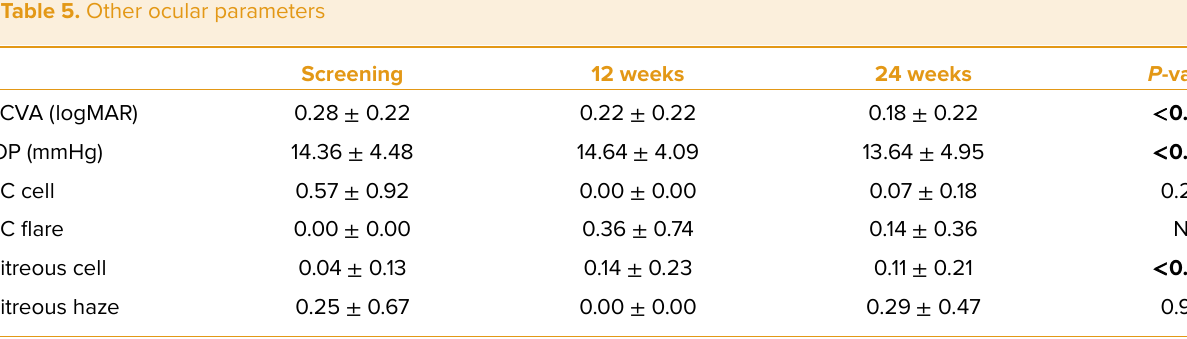
Table 5. Other ocular parameters